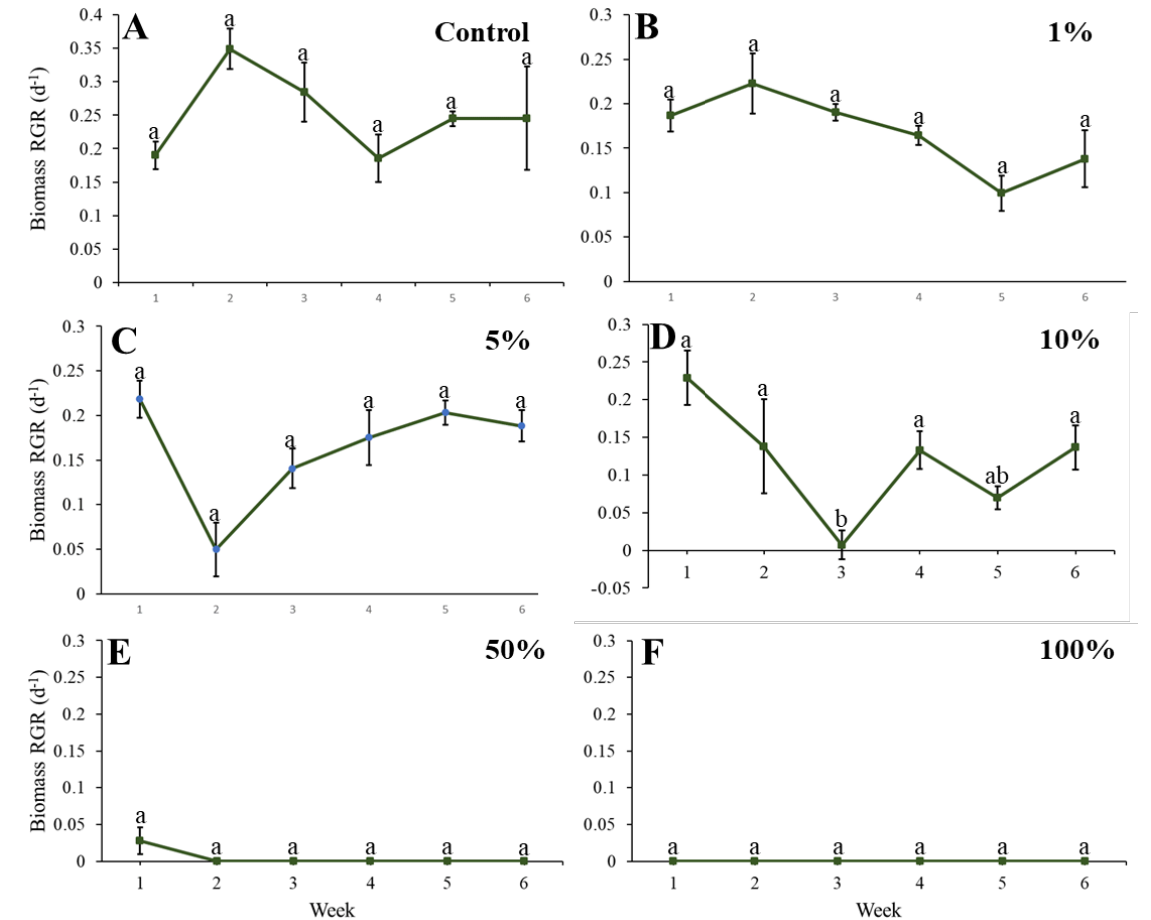
Figure 2. Mean (±SE) RGR (d ⁻ 1 ) of Lemna minor growth for the control treatment (panel A), as well as on 1%, 5%, 10%, 50%, and 100% AD-DPW (panel B, C, D, E and F, respectively) over the course of the six successive weeks. Different letters within each panel denote statistical differences between weeks. For individual weeks, RGR was greater for plants grown on the control (half-strength Hutner’s medium), 1%, 5%, and 10% concentrations than for duckweed cultivated on 50% and 100% concentrations: week 1 (all p < 0.05), week 2 (all p < 0.05), week 3 (all p < 0.01; except the 10% solution, p > 0.05), week 4 (all p < 0.01), week 5 (all p < 0.01), week 6 (all p < 0.01). The concentration of total phosphorus (TP) within the tiered tank system was signifi- cantly reduced between day 0 and day 7, in both 5% and 10% AD-DPW (both p < 0.001). Similar to TN, TP was found to significantly differ across treatments and time-points (GLM: χ 2 = 29.233, df = 3; p < 0.0001, Figure 4). The tested media (5% and 10% AD-DPW) and sampling day (day 0 or day 7) were found to have a significant effect on TP concentration ( p < 0.05 and p < 0.0001, respectively). No significant interaction effect was detected. The removal rate of TN and TP from AD-DPW by L. minor was determined by calcu- lating the difference between the initial (day 0) and final (day 7) nutrient concentrations and expressing it per m − 2 duckweed per day. The 5% AD-DPW had nutrient removal rates of 43.72 mg TN m − 2 d − 1 and 53.76 mg TP m − 2 d − 1 while 10% AD-DPW had higher nutrient removal rates of 248.46 mg TN m − 2 d − 1 and 126.54 mg TP m − 2 d − 1